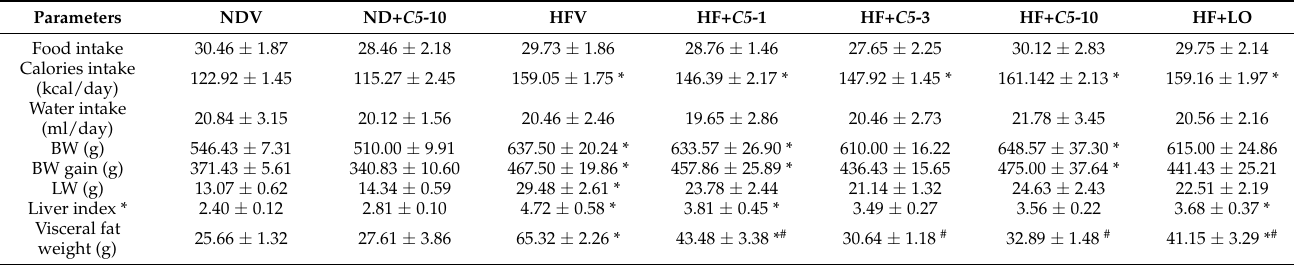
Values shown are mean ± S.E.M ( n = 6), * p < 0.05 represents the significant difference compared with the NDV group; # p < 0.05 represents the significant difference compared with the HFV group. * Liver index was calculated by liver weight divided by body weight and multiply by